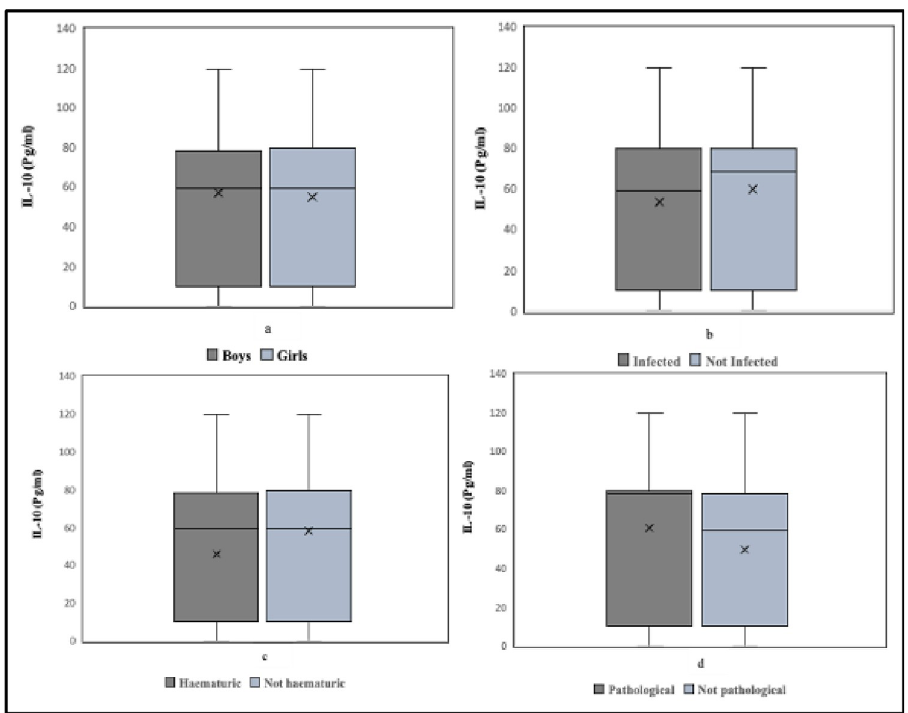
Fig 4. Box plot showing urinary IL-10 levels in relation to (a) sex, (b) S . haematobium infection, (c) haematuria and, (d) urinary balder pathology. Solid lines represent the median; X represents the mean and error bars represent the